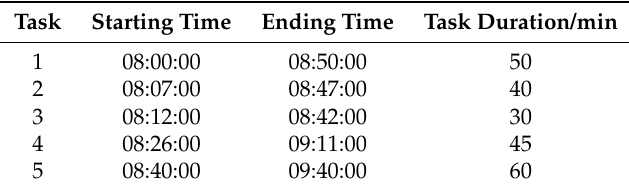
Table 2. Sensing task